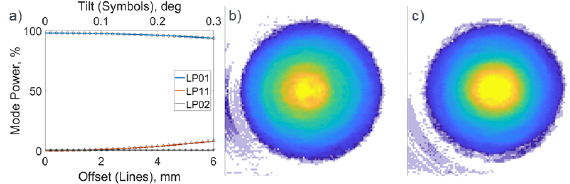
Figure 3. a) Mode content of LP 01 , LP 02 , and the dominantly excited spurious mode LP 11 for an either tilted (symbols) or o ff set (lines) gaussian input beam. For negligible beam truncation, the values can also be related to the points of maximum tilt or o ff set in Fig. 1. b) Linear amplitude of 2D field scan with approx. 0.5 % LP 02 content. c) Linear amplitude of 2D field scan with approx. 5 % LP 02 content.